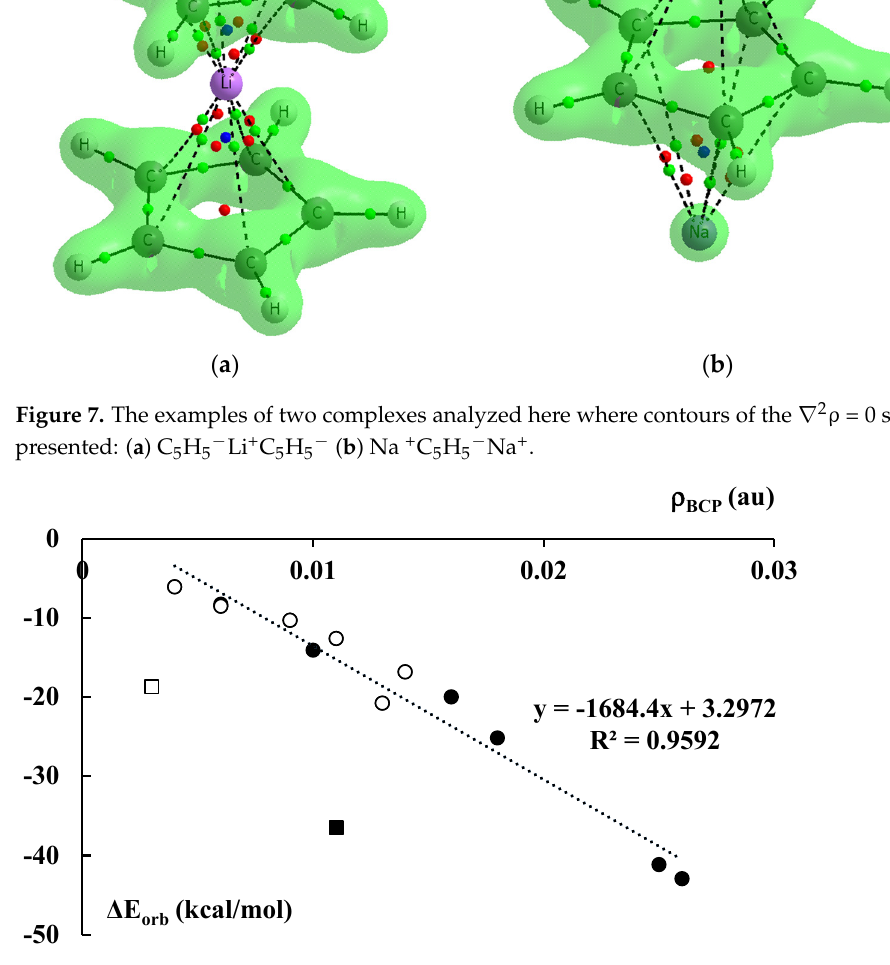
Figure 8. The dependence between the electron density (in au) at the C ··· Li + /Na + BCP of the corresponding bond path and the orbital–orbital interaction energy term (Equation (1), in kcal/mol) for the corresponding cation–cyclopentadienyl anion contact. Black and white circles correspond to the lithium and sodium species, respectively. Black and white squares not included in the correlation presented correspond to the Li + C 5 H 5 − ··· Li + and Na + C 5 H 5 − ··· Na + species, respectively.